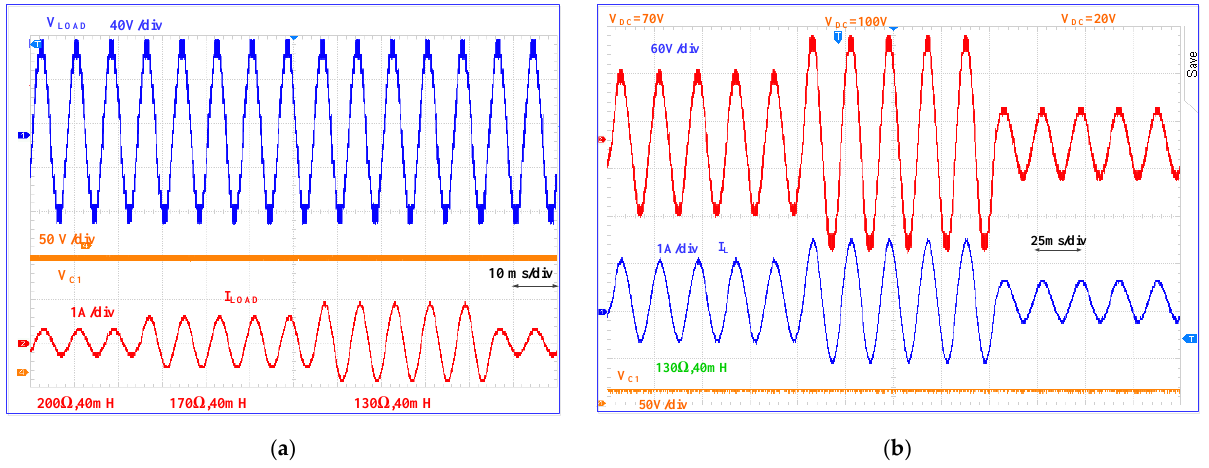
Figure 15. ( a ) Output voltage, current waveforms and DC link voltage for variable load. ( b ) Output voltage, current waveforms and DC link voltage for variable DC source voltage.